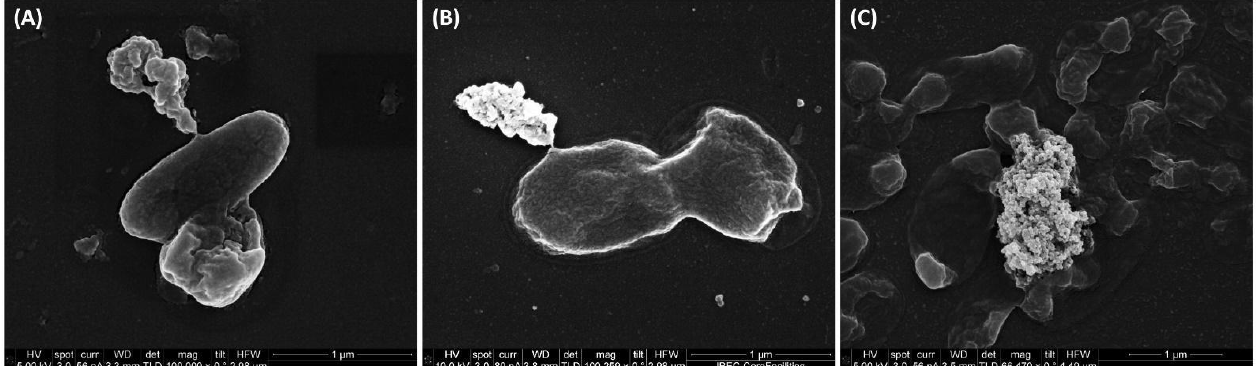
Figure 1. One-step growth curve of ( A ) IBEC48 phage, ( B ) IBEC77 phage, and ( C ) IBEC36 phage. One-step growth curves were obtained by growing IBEC 48, IBEC 77, and IBEC 36 with there exponentially growing culture of E. coli MG1655, E. coli CFT073, and E. coli LF82 strains respectively. Data points indicate the PFU/mL at different time points. Each data point represents the mean of three independent experiments.